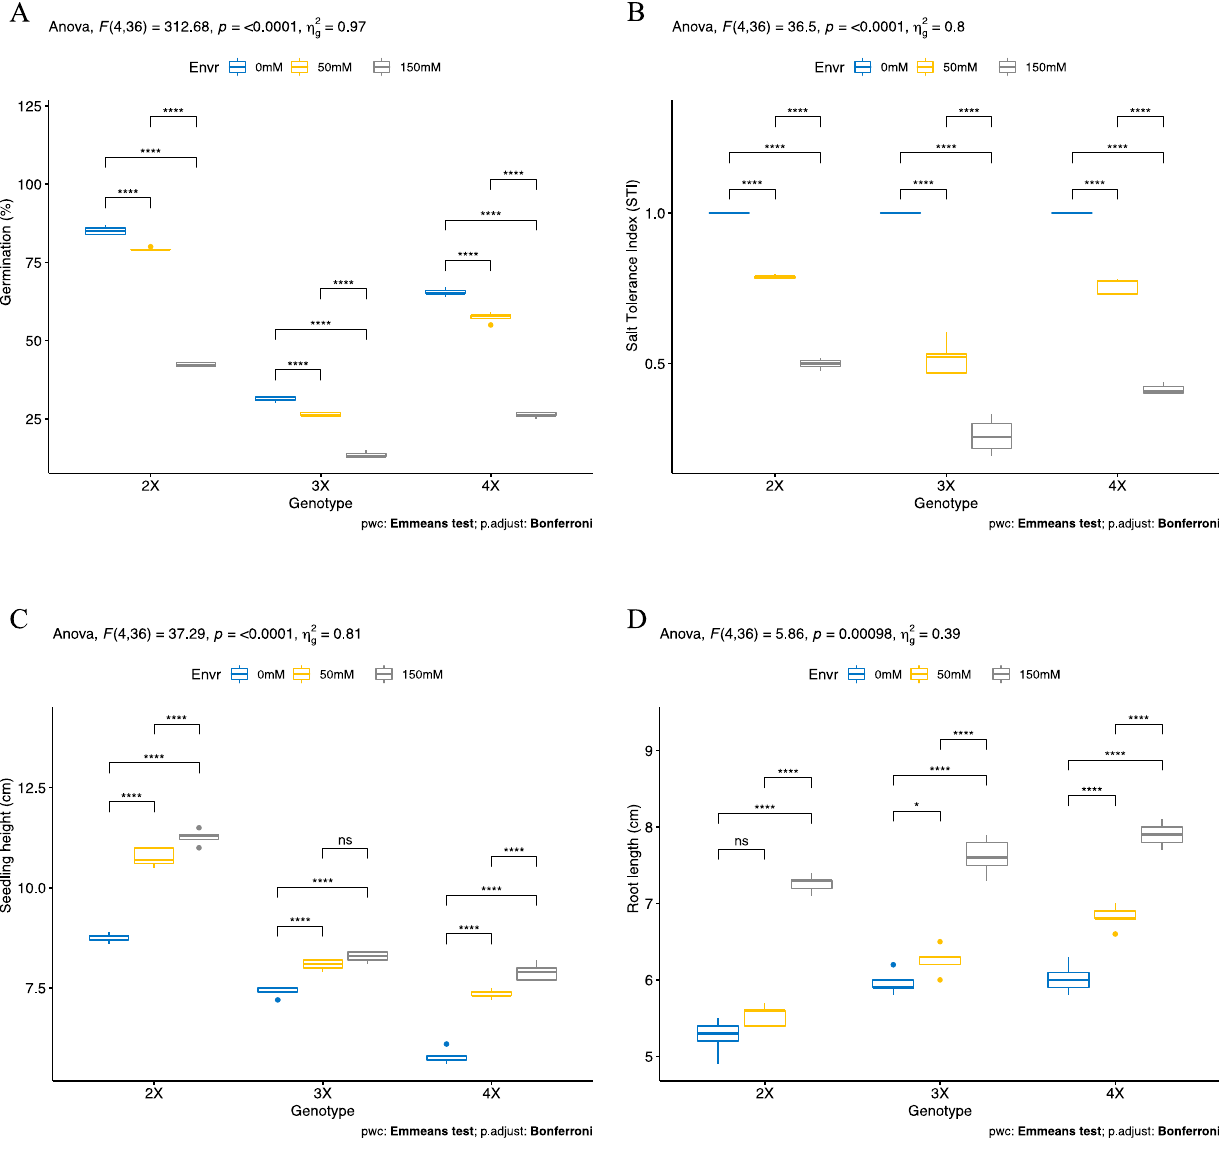
Figure 1. Effects of salinity stress on growth performance of different ploidy level sugar beet plants ( Beta vulgaris L.) in the seedling stage. ( A ) Germination percentage, ( B ) salt tolerance index (STI), ( C ) seedling height, and ( D ) root length. Germination percentage was determined on the fourth day after the study began, and seedling height and root length were measured in 14-day-old seedlings that were exposed to the salt stress from germination. Means (± standard deviation) within the same graph, followed by the Emmeans test and p -value adjusted by the Bonferroni method from five independent biological replicates ( n = 5). Asterisk indicates that ns—non-significant; * significant at p ≤ 0.05; **** significant at p ≤ 0.0001.